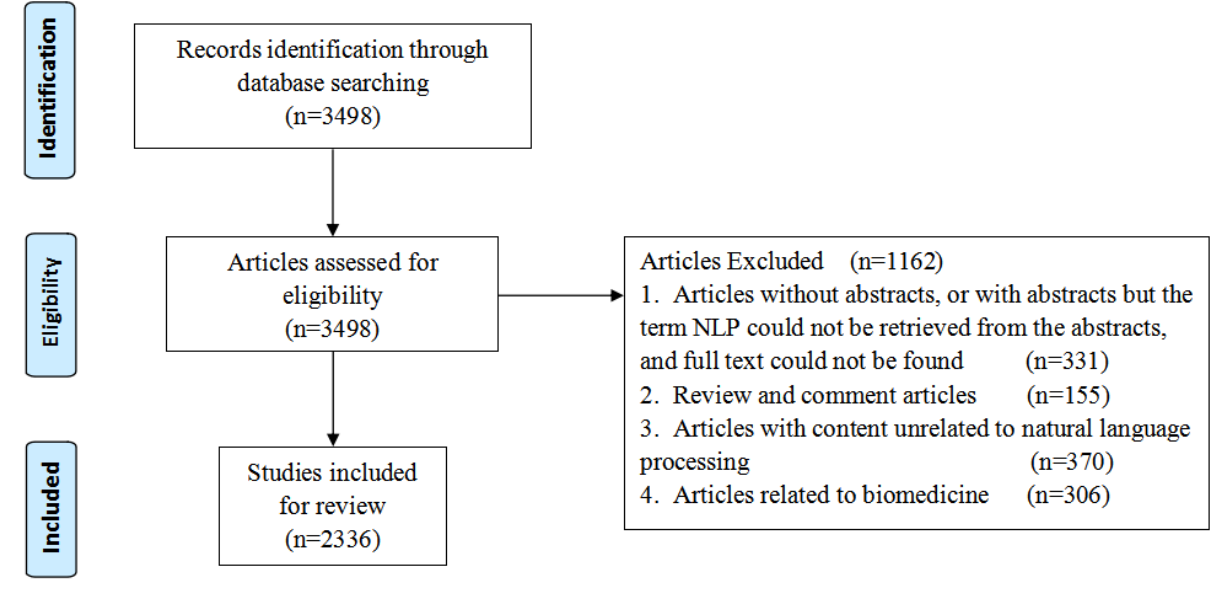
Figure 1. Preferred Reporting Items for Systematic Reviews and Meta-Analyses flow diagram depicting the screening procedure for articles on natural language processing (NLP) in the medical